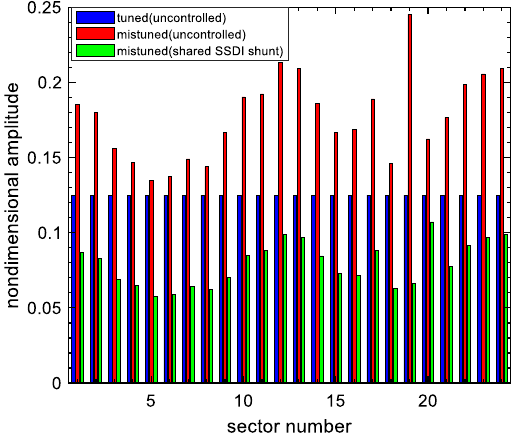
Figure 19. Response amplitude of 24 blades in three configurations (tuned, mistuned with and without dual-connected